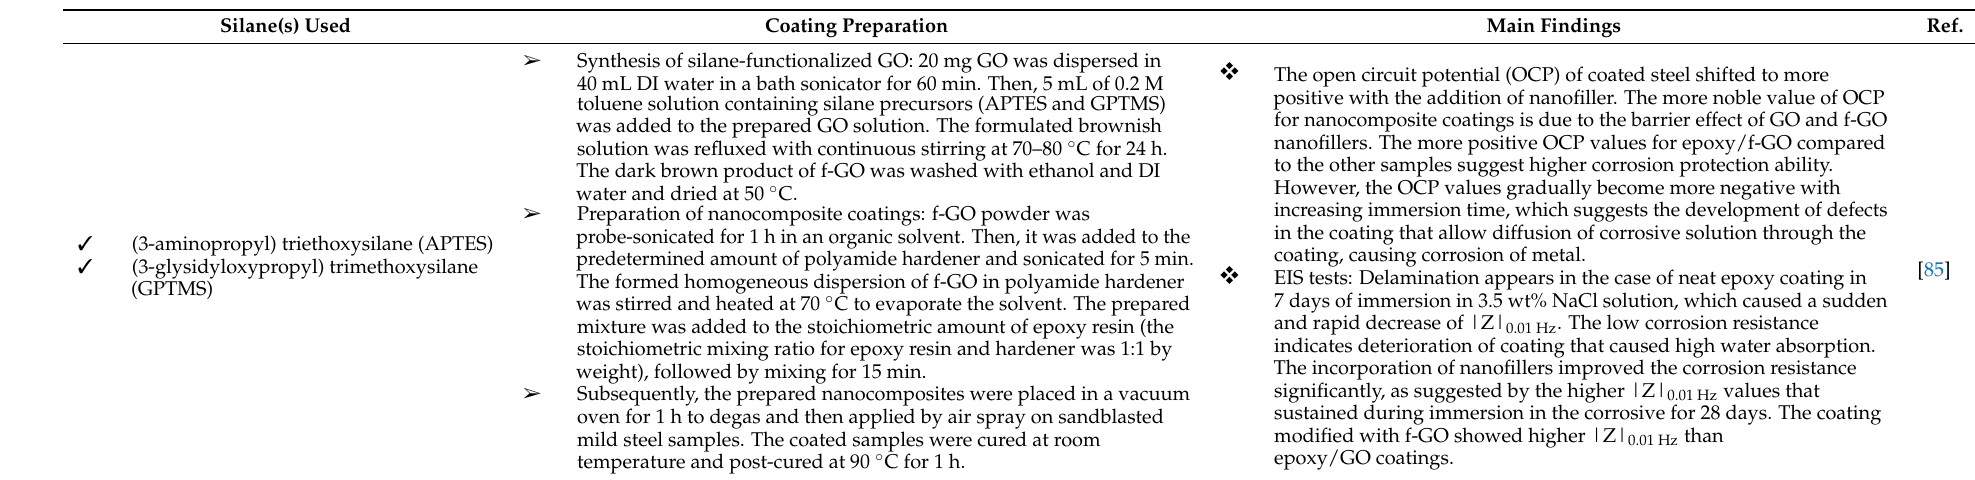
Table 1. Cont . Table 1. Different approaches for improving silane coatings and the main findings, as reported in the literature. Coating Preparation Main Findings Ref. Silane(s) Used Coating Preparation Main Findings Ref.